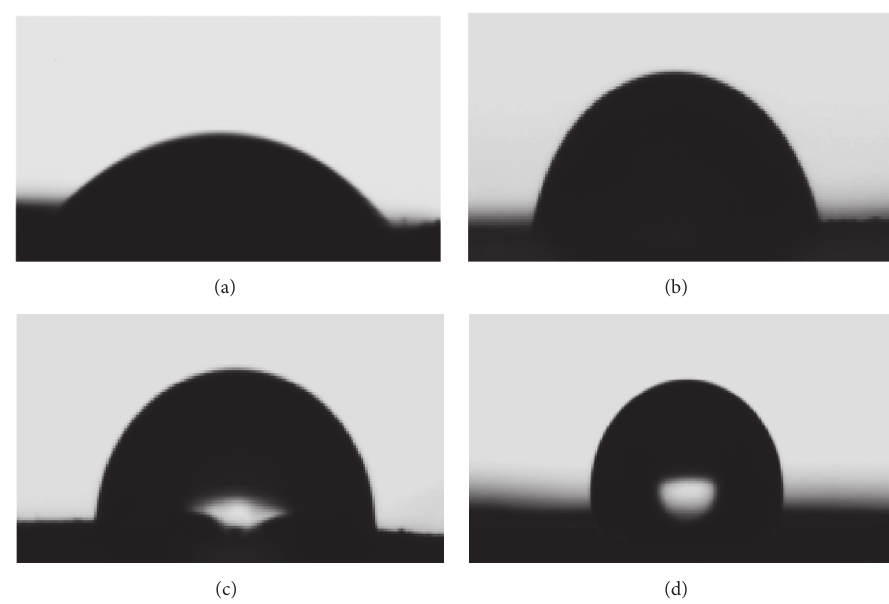
Figure 3: WCA measurements of PVA and ZnO-PVA nanofibrous membranes. (a) PVA (WCA = 36 ∘ ), (b) ZnO-2 (WCA = 78 ∘ ), (c) ZnO-3 (WCA = 86 ∘ ), and (d) ZnO-4 (WCA = 107 ∘